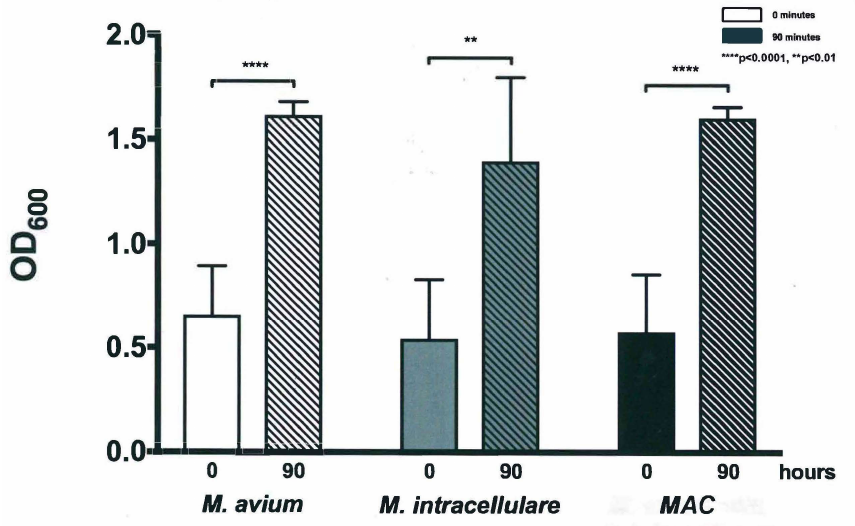
Figure 2. Optical density of M. avium , M. intracellulare , and MAC ( M. avium combined with M. intracellulare ) at time zero and 90 h. M. avium and MAC ( M. avium with M. intracellulare ) demonstrated increased OD at a significance of **** p < 0.0001 according to two-tailed, paired T -test analysis. The increased OD of M. intracellulare was also significant, but at ** p < 0.01, n = 7.